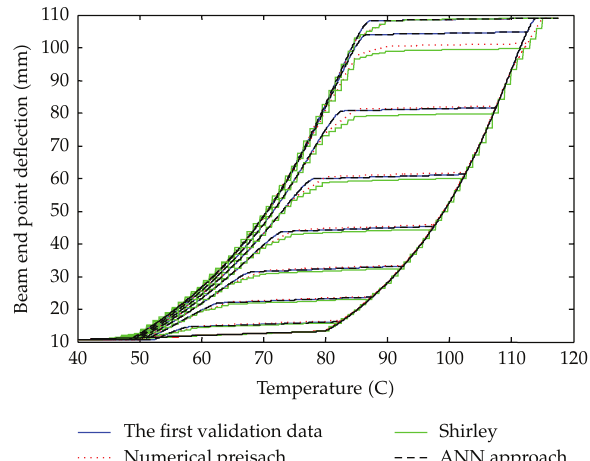
Figure 18: Prediction of the hysteresis behavior for the classical numerical Preisach, Proposed ANN Model and Shirley Approach in comparison to the first experimental data